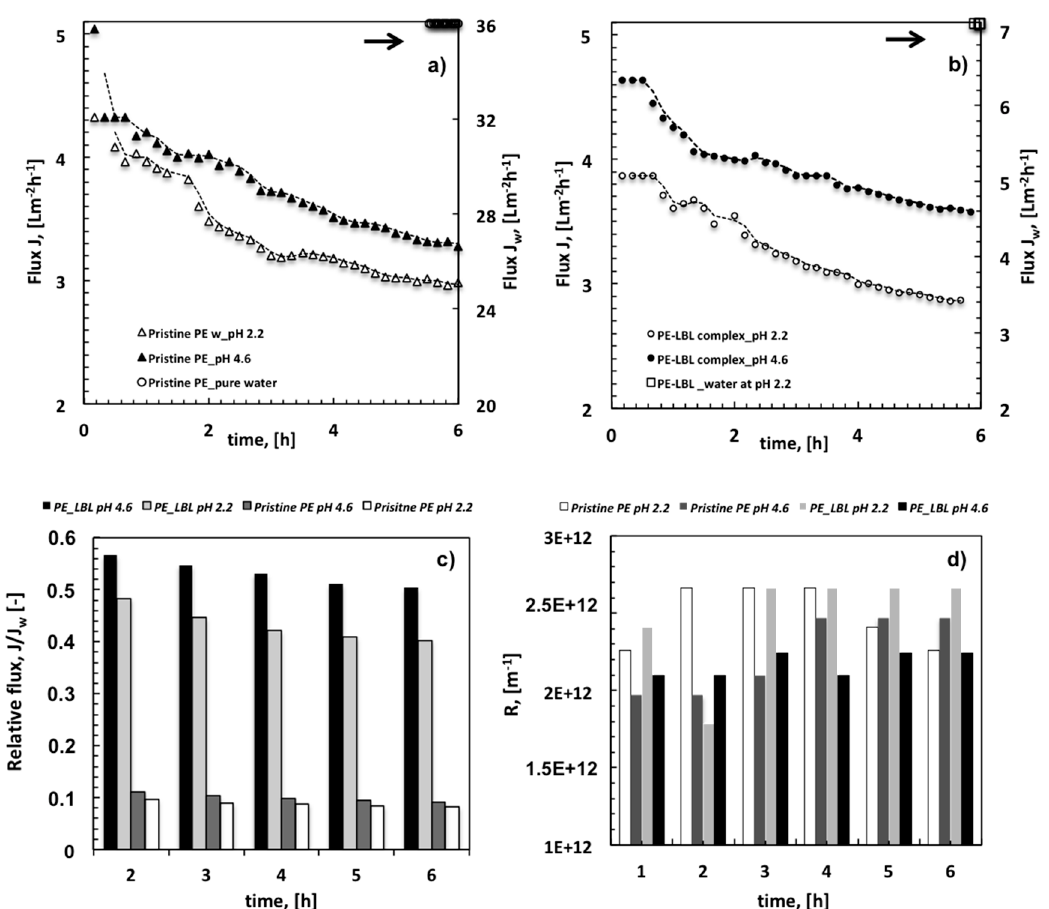
Figure 7. Average Flux ( a , b ), relative flux ( c ) and resistance to the flux ( d ) measured with time through pristine PE and PE-LBL membranes coming in contact with pure water and OMW solutions at pH 2.2 and 4.6 and under irradiation.